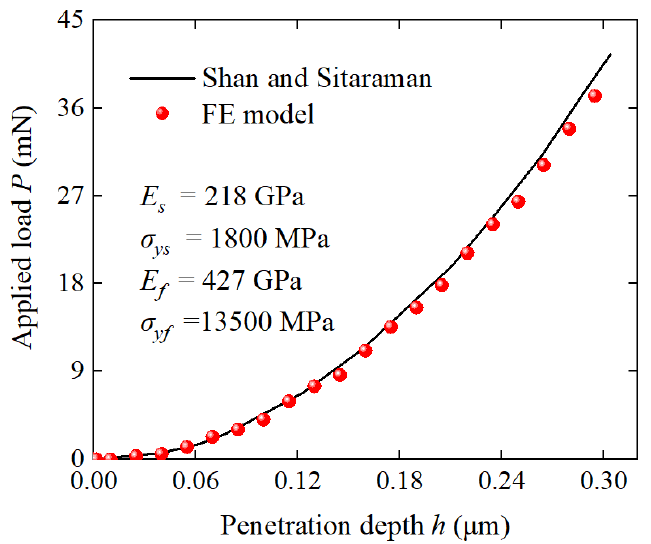
Figure 5. Response comparison of the established FE model and the published result [36].